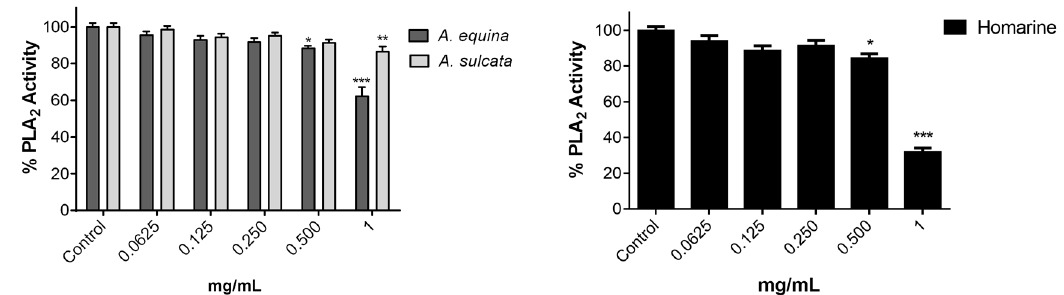
Figure 5. Effect of both sea anemones aqueous extracts and homarine on PLA 2 activity in a non-cellular system. Results are presented as mean ± standard error of the mean of four independent experiments performed in triplicates. Statistical significance: * p < 0.05, ** p < 0.01, *** p < 0.001.